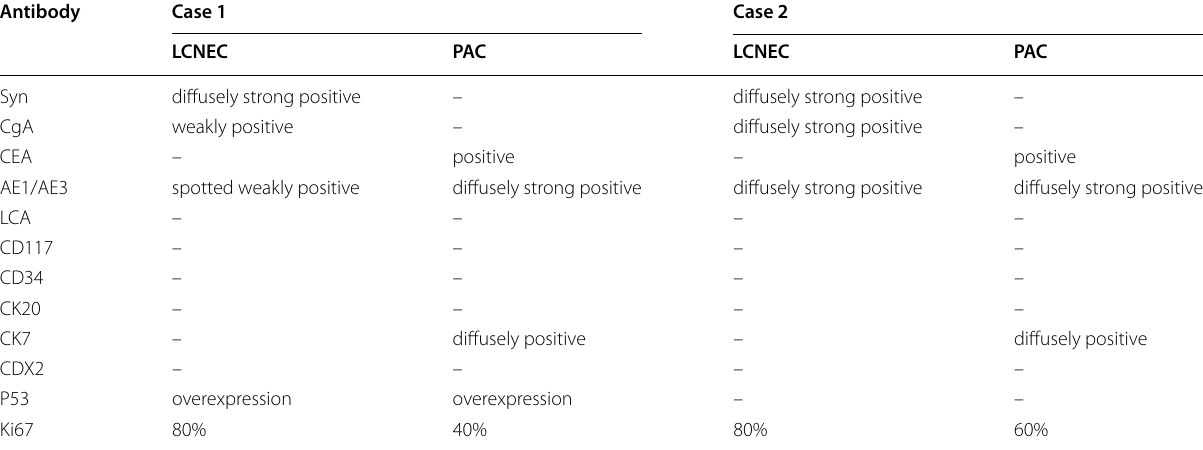
PAC Papillary adenocarcinoma, Syn Synaptophysin, CgA Chromogranin A, overexpression: > 80%;